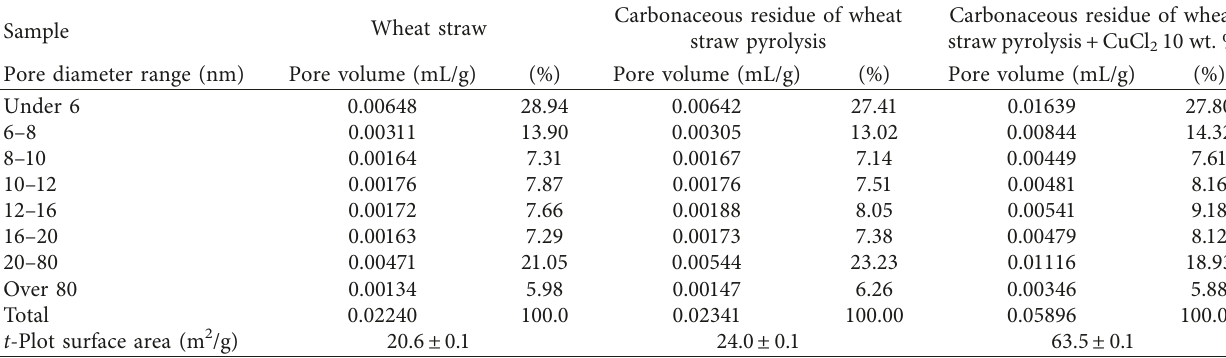
Table 2: Analysis of the porosity of the initial wheat straw and pyrolysis solid